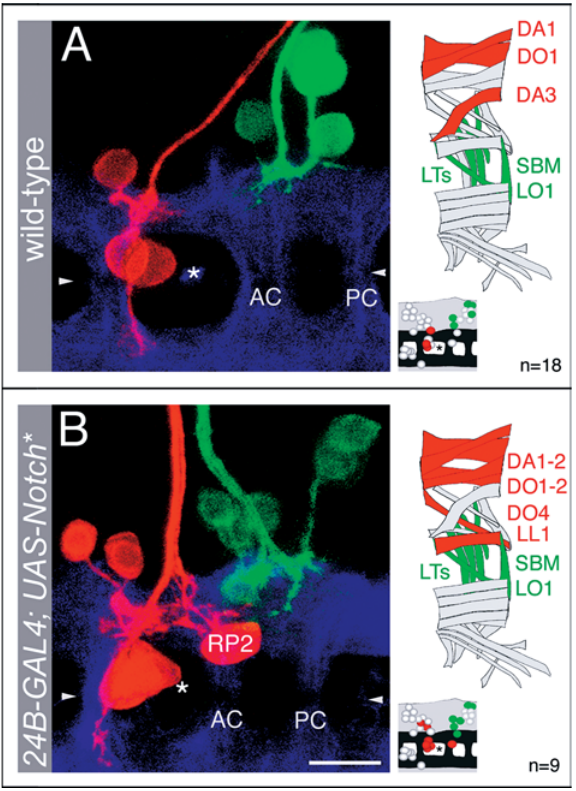
Figure 6. The Myotopic Map Forms Independently of Target Muscles ISN motor neurons (red) with internal and SN motor neurons (green) with external muscle targets in a 15-h-old wild-type (A) and in an embryo, in which muscle formation had been suppressed by targeted expression of an activated form (intracellular domain) of Notch ( 24B - GAL4 ; UAS - Notch *) (B). In such muscleless embryos, the main nerve trunks (ISN and SN) still form and project into the periphery along distinctive paths. Thus, motor neurons whose axons project through these nerves can be retrogradely labelled. The neuropile, visualised with anti-HRP, is shown in blue. ISN and SN motor neuron dendritic domains show a normal separation despite absence of target muscles. Note that the ISN (red) and SN (green) dendritic arbors in (B) appear to be in closer proximity than those shown in (A). This is because in (B) the RP2 neuron (indicated) is labelled, which is the most posterior of the ISN motor neurons and therefore closest to the SN dendritic domain. See also Figure 2G, where RP2 and its dendrites are shown relative to the most posterior of the SN motor neuron (SBM) dendritic fields. Anterior is left and dorsal is up. Symbols and abbreviations: triangles, ventral midline; AC, anterior commissure; PC, posterior commissure; asterisks, dorsoventral channels (landmarks for the segment borders). Scale bar (not applicable to diagrams of CNS